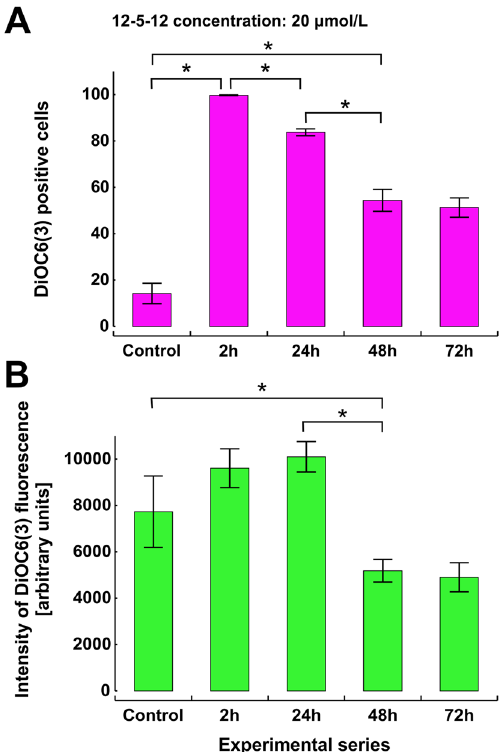
Figure 5. The changes in the membrane potential in the fraction of viable cells. The membrane potential was estimated with DiOC6(3) during the following hours of exposure to the 12-5-12 surfactant at the concentration of 20 μmol/L. ( A ) The percentage of DiOC6(3) positive cells. ( B ) The intensity of DiOC6(3) fluorescence. The columns show mean values and the error bars represent standard deviation from three independent